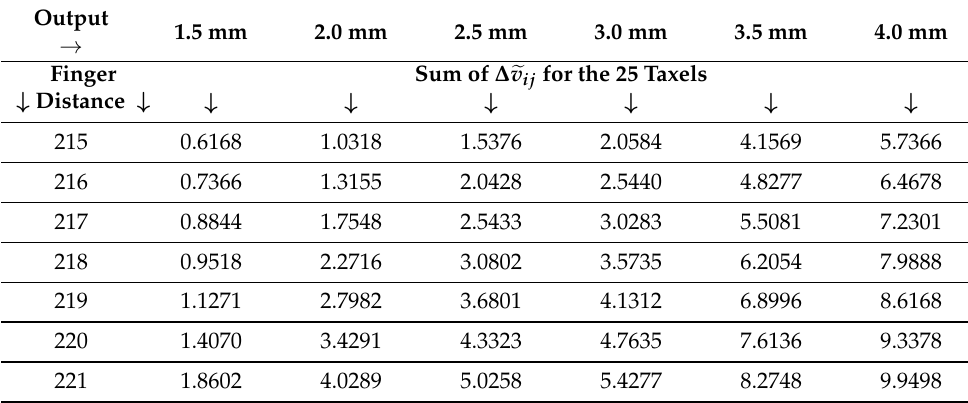
Table 2. Some rows of the lookup table for the